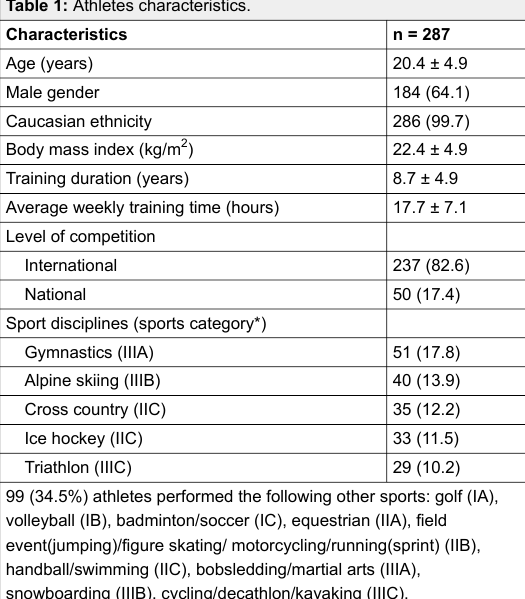
Table 1: Athletes